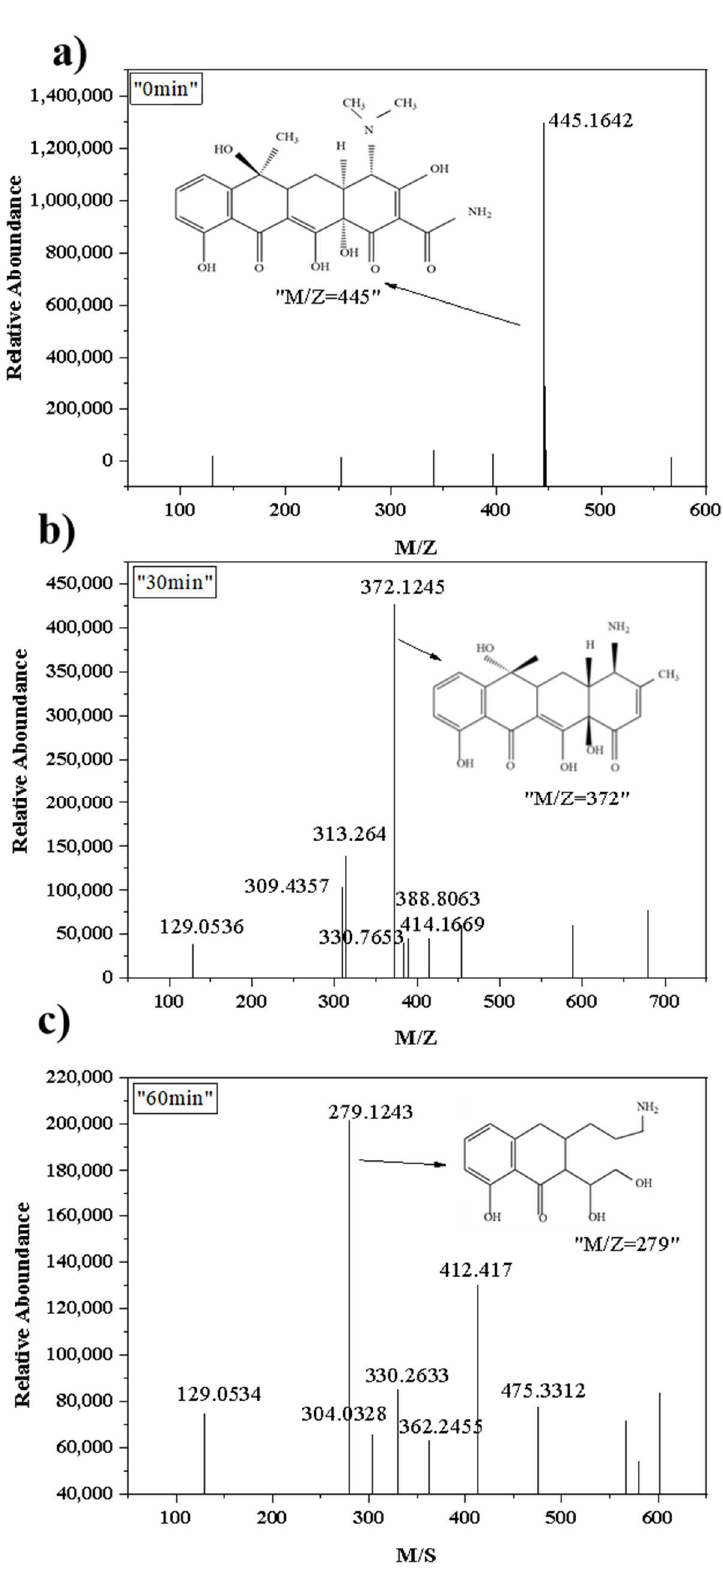
Figure 8. ZnO-C/MnO 2 processing TC mass spectrum. ( a ) 0 min; ( b ) 30 min; ( c ) 60 Figure 8. ZnO‐C/MnO 2 processing TC mass spectrum.